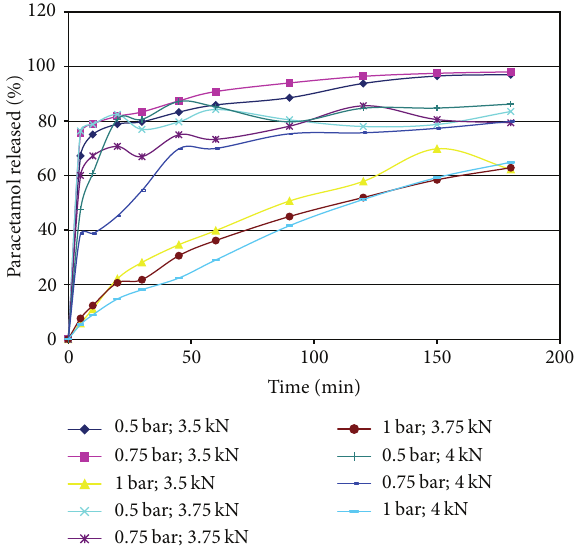
Figure 2: Dissolution profiles of paracetamol from nine tablets series.